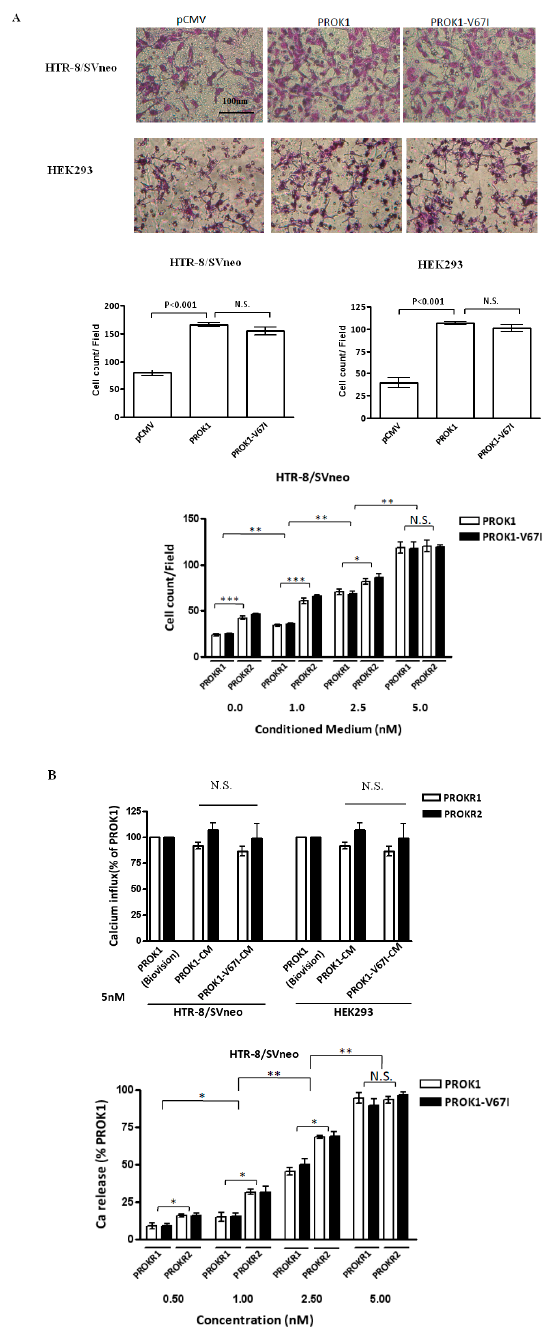
Figure 4. PROK1-V67I and -WT ( A ) enhanced cell invasion ability and ( B ) altered intracellular calcium influx in a dose-dependent manner. PROKR2-transfected cells had increased abilities of inducing calcium release and cell invasiveness compared with PROKR1-transfected cells. HEK 293 and HTR-8/SV neo cells were transiently transfected with control vector, WT or variant PROK1 construct. Photographs and quantification of invaded cells stained with Giemsa’s azur eosin methylene blue solution are shown in the upper and middle panels in A . HEK293 and HTR-8/SV neo cells were transiently transfected with either PROKR1 or PROKR2 plasmid and treated with various concentrations of PROK1 WT or V67I condition medium (0, 1.0, 2.5, 5.0 nM). Invaded cells ( A , lower panel) and intracellular cell influx alternation ( B , upper and lower panels) were measured. * p < 0.05; ** p < 0.01; *** p < 0.001 compared between PROKR1- and PROKR2-transfected cells, and groups of different concentration. PROK1 recombinant protein (Biovision, Milpitas, CA, USA) was used as a standard control to validate protein function of PROK1 (WT) and PROK1-V67I in condition medium (CM). N.S.: no significant difference.